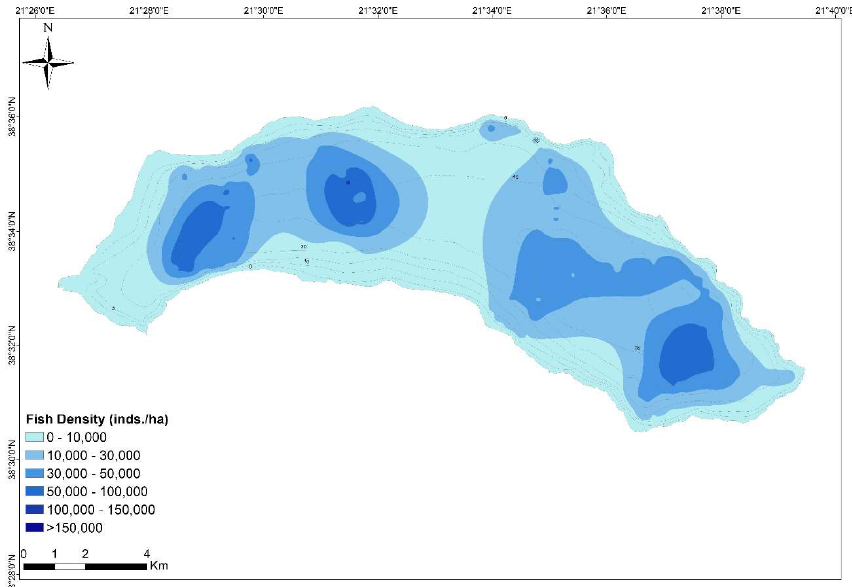
Figure 9. Fish density (inds. / ha) distribution during the day survey in lake Trichonis.